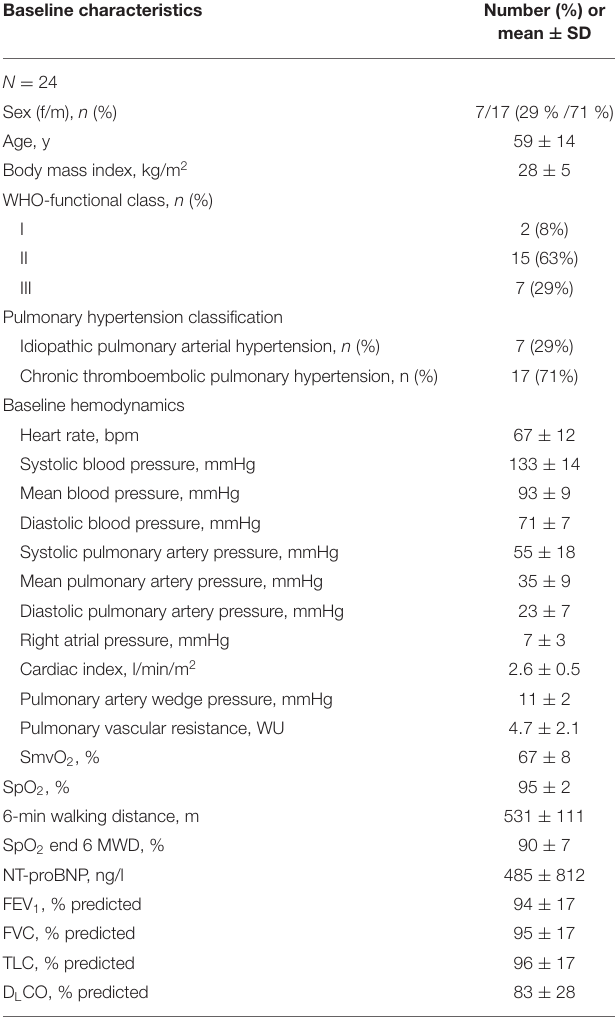
TABLE 1 | Baseline